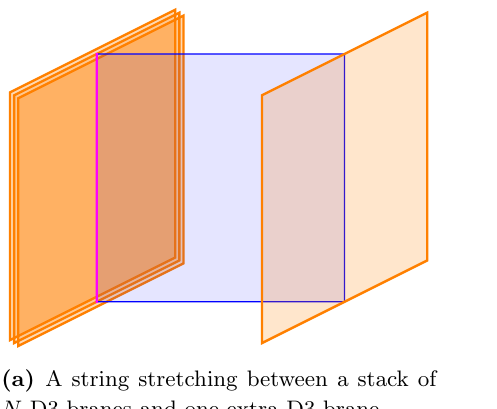
Figure 1. The Higgsing procedure of four-dimensional N = 4 SYM theory in the dual string theory description. In (a) the magenta line is the Wilson loop. In (b) the blue cross on S 5 represents the point where the string is localized in the internal